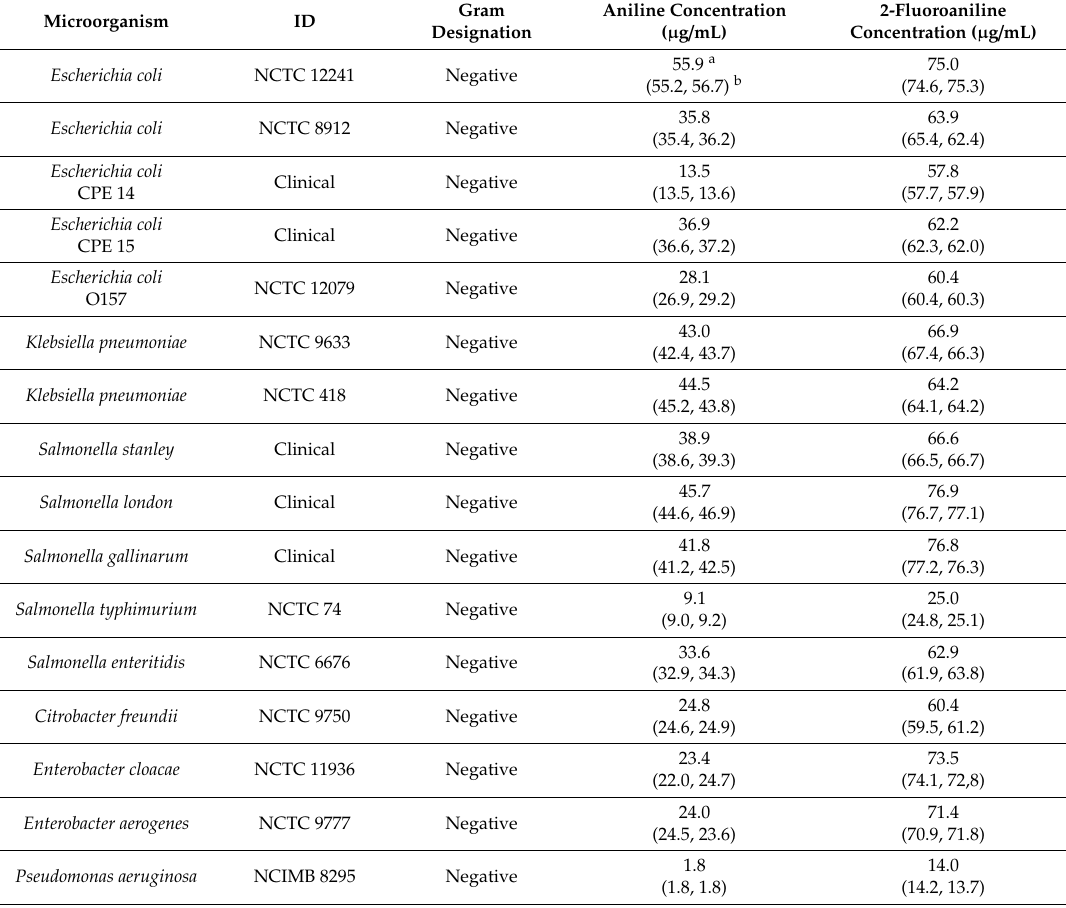
Table 2. VOC production of various microorganisms in brain heart infusion (BHI) broth following overnight incubation at 37 ◦ C with an inoculum of 1 × 10 6 CFU / mL and a substrate concentration of 100 µ g /